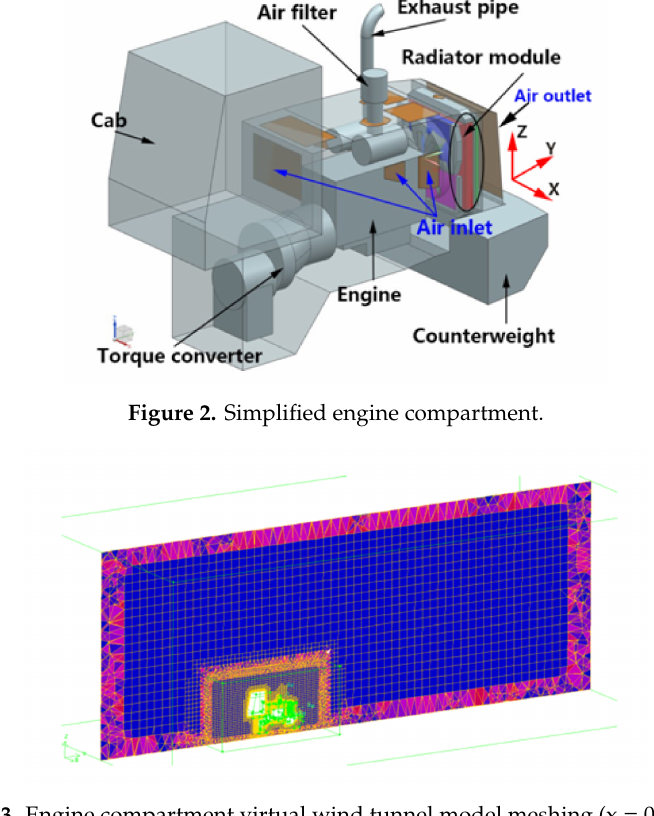
Figure 3. Engine compartment virtual wind tunnel model meshing (x = 0 section).